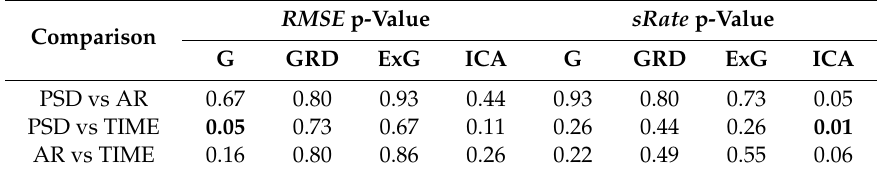
Table A10. The Wilcoxon rank sum test results (p-values) for comparing di ff erent algorithms. Comparison